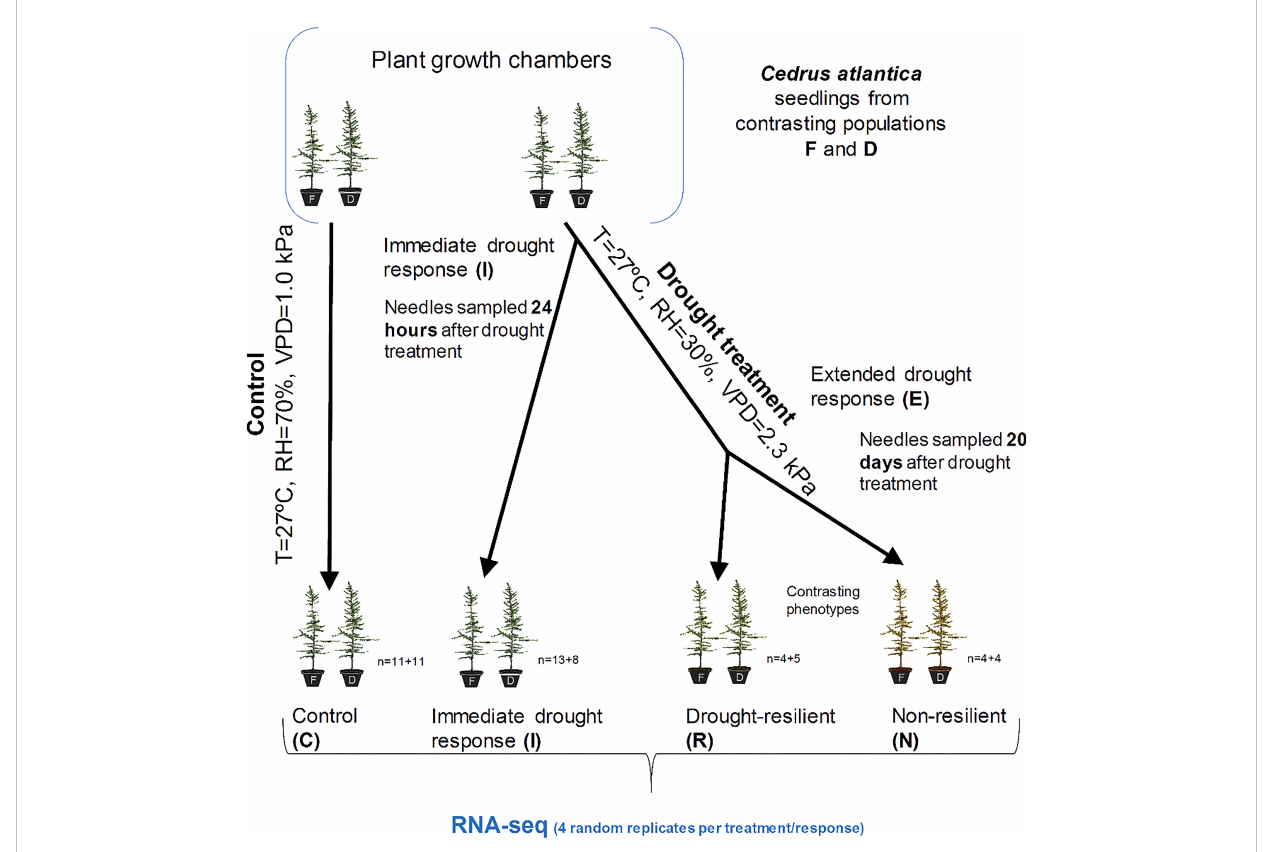
FIGURE 2 Drought treatment experimental design and sampling procedure. Net photosynthesis (A) and stomatal conductance (Gs) were monitored in controls (C), immediate drought ( I , after 24 hours of drought treatment), and extended drought (E, after 20 days of drought treatment).The E group was divided into drought resilient seedlings (R) and non-resilient seedlings (N), based on recovery capacity after the extended drought. T, temperature; RH, relative humidity; VPD, vapor-pressure de fi cit; n indicates the number of individuals from Fiñana (F) and Dornajo (D), respectively